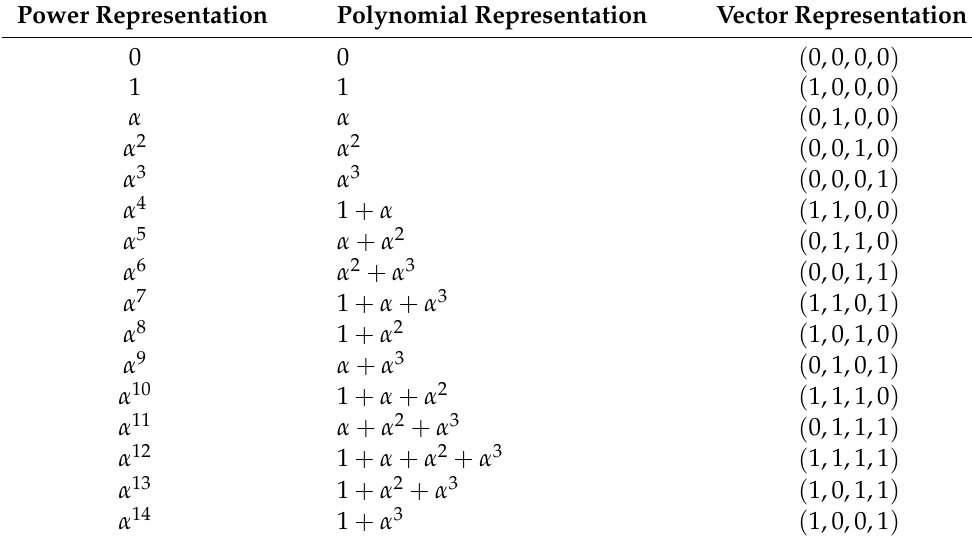
Table 2. Representation of the Galois Field GF ( 2 4 ) over GF ( 2 ) with primitive polynomial p ( x ) = 1 + x + x 4 over GF ( 2 )